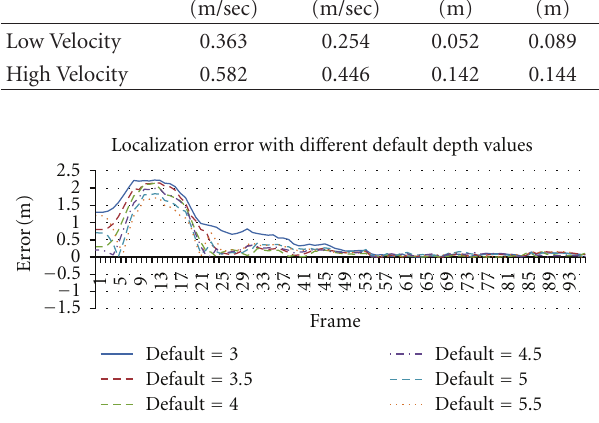
Figure 10: The unknown depth of the target is estimated by sequential images with EKF and six cases (3.0m, 3.5 m, 4.0m, 4.5m, 5.0 m, and 5.5 m) are assumed to be default depths for each experiment case.